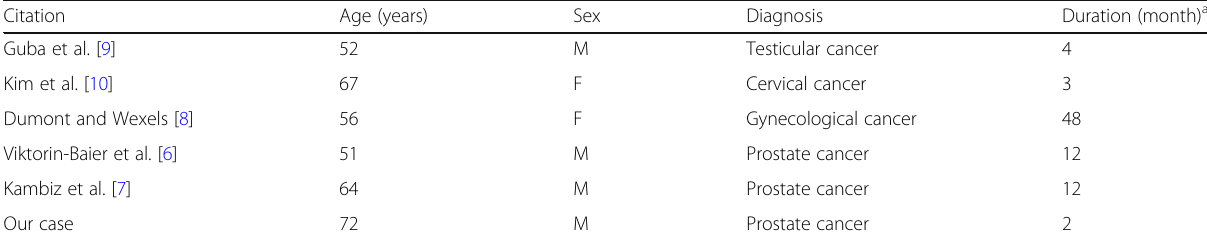
Table 1 Reported cases of internal hernia formation beneath the external iliac artery after extended pelvic lymph node dissection (including our